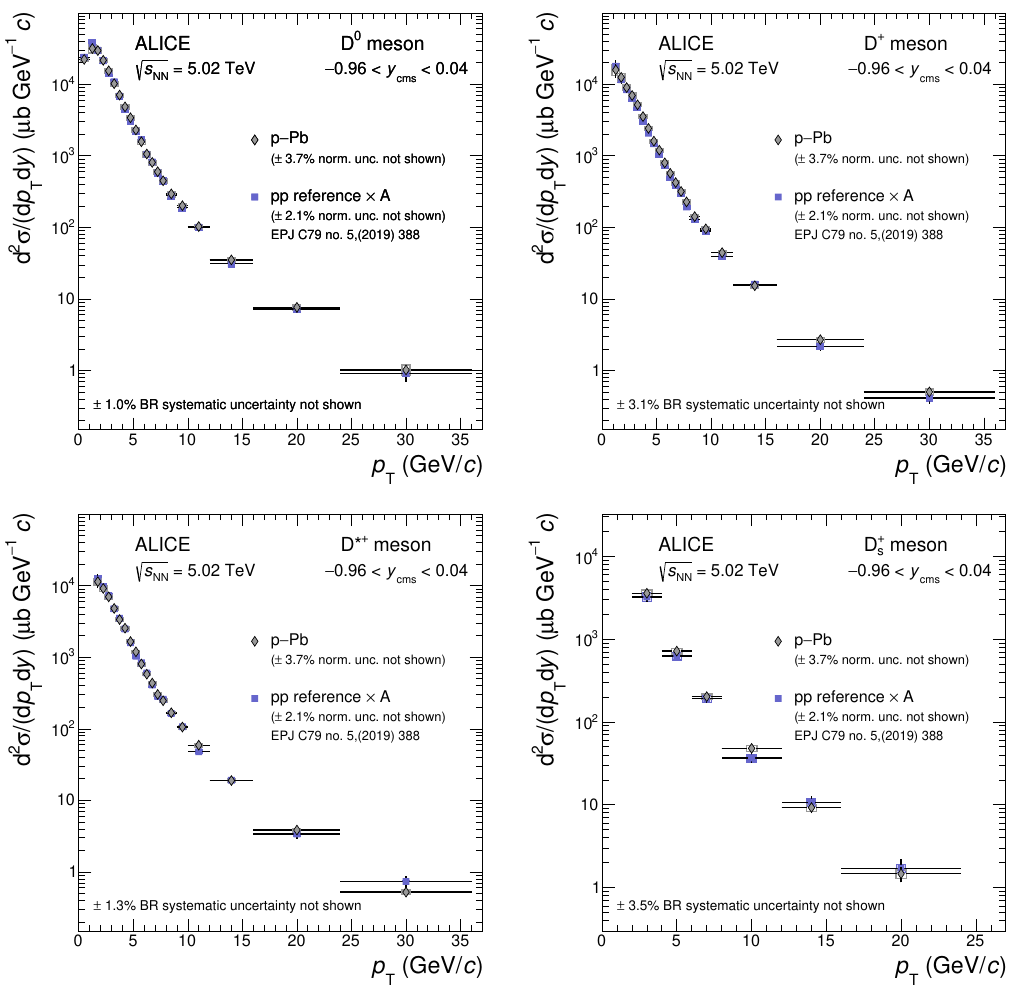
Figure 7 . p T -di(cid:11)erential production cross sections of prompt D 0 , D + , D (cid:3) + , and D + mesons s p with (cid:0) 0 : 96 < y cms < 0 : 04 in p{Pb collisions at s = 5 : 02 TeV compared with the respective NN pp reference cross sections [70] scaled by the Pb mass number ( A = 208) and corrected for the rapidity shift. For the D 0 meson, the results in the range 0 < p T < 1 GeV =c are obtained from the analysis that was performed without decay-vertex reconstruction, while those in the range 1 < p T < 36 GeV =c are taken from the analysis with decay-vertex reconstruction. The vertical bars and the empty boxes represent the statistical and systematic